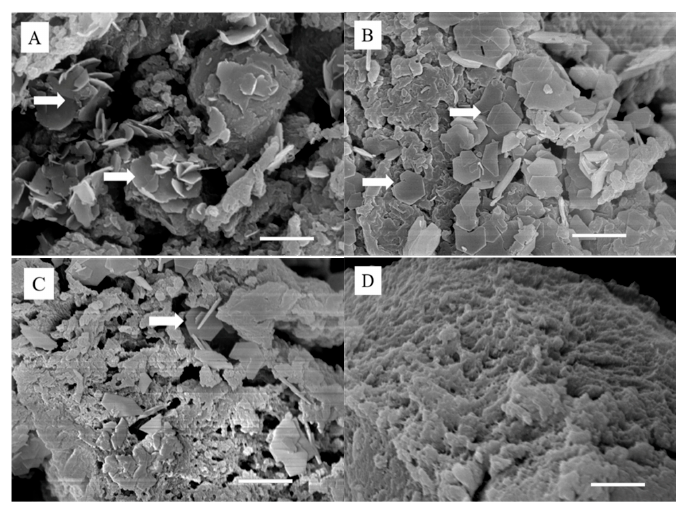
Figure 2. The SEM analysis of the surface morphology of ( A ) PAA–0.1M, ( B ) PAA–0.05M, ( C ) PAA– Figure 2. 0.025M and ( D ) PAA (white arrows represent simonkolleite crystals, the scale bar: 2 μ m) . Table 1. The EDS data of the PAA–0.1M, PAA–0.05M and PAA–0.025M surfaces.